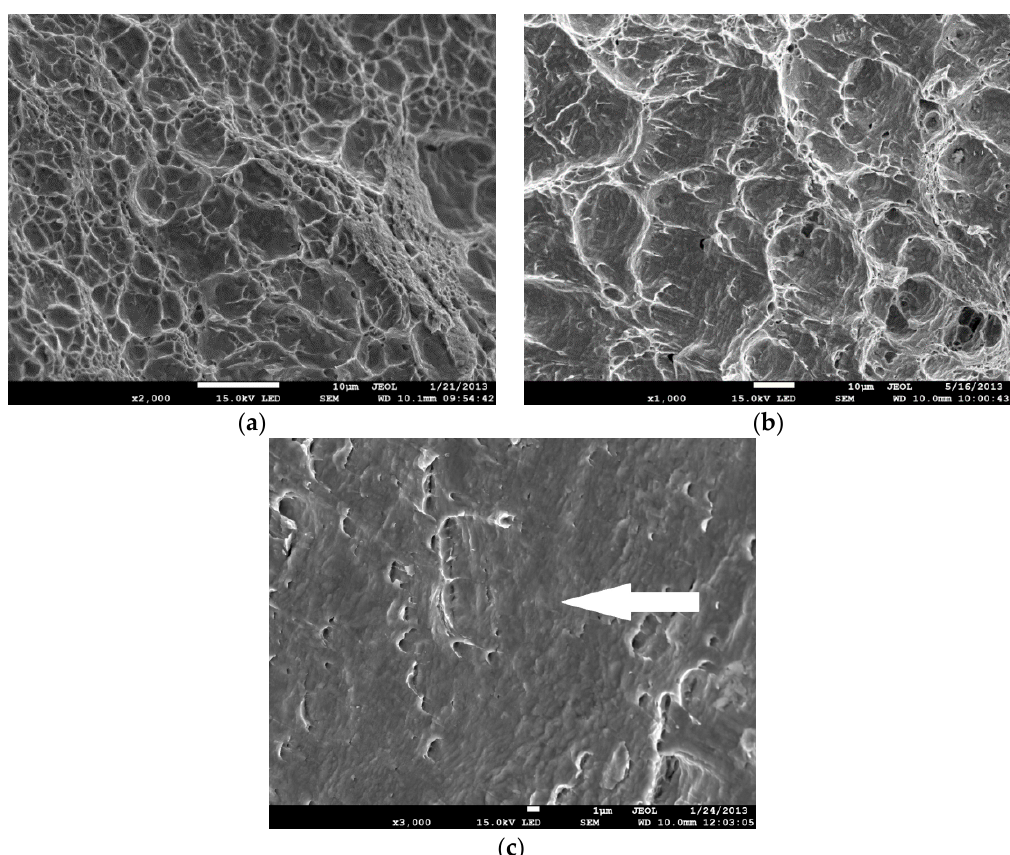
Figure 1. The influence of stress triaxiality on the ductile fracture mechanism. Material Hardox-400 (Source: own research). ( a ) Dimples in front of the crack, central part of the specimen ( η = 2.5). ( b ) Dimples in front of the crack, located at the mid-part of the shear lips. Parabolic shape of the dimples is due to the shear stress ( η = 1.6). ( c ) The traces of dimples in front of the crack, located close to the specimen surface–shear lips ( η = 0.9). Arrow points to the shear planes and failure domain due to the dislocations slip.